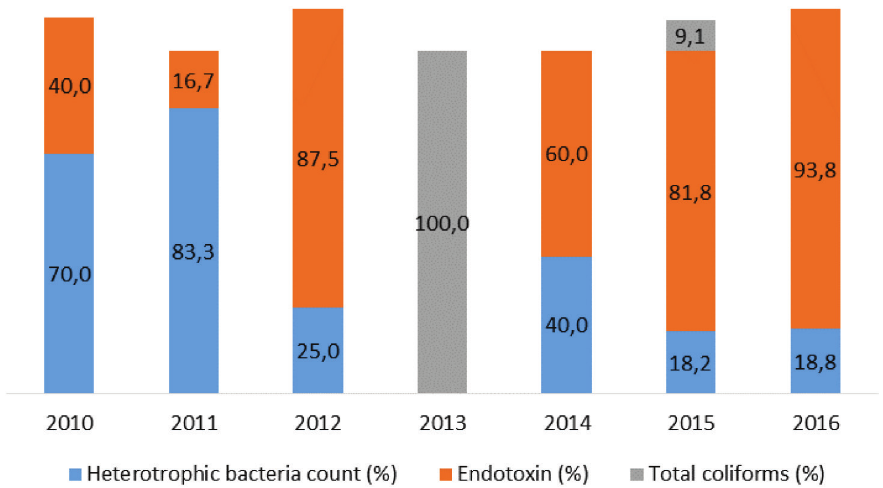
FIGURE 5 – Profile of unsatisfactory results for the second water sample collection in dialysis units in São Paulo State, Brazil, from 2010 to